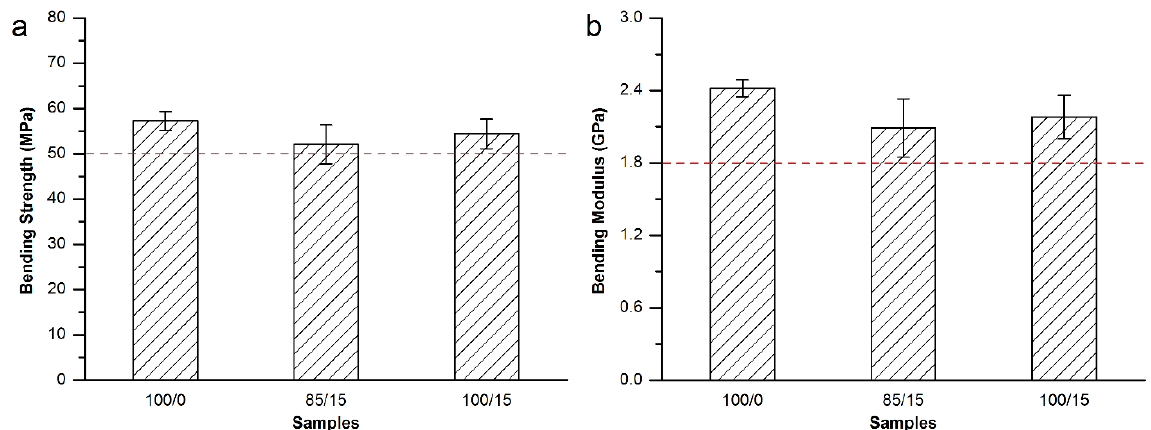
Figure 6. ( a ) Bending strength and ( b ) bending modulus of the MC modified Mendec ® Spine bone cement.